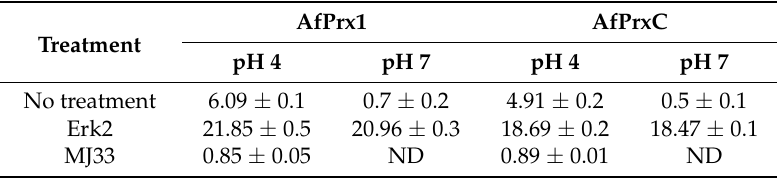
Table 3. PLA 2 specific activity (nmol/min/mg protein) for non-mammalian Prdx6 in different pH, phosphorylation treatment with Erk2 and after inhibition with 1-hexadecyl-3-trifluoro-ethylglycero- s n -2-phosphomethanol (MJ33). ND: